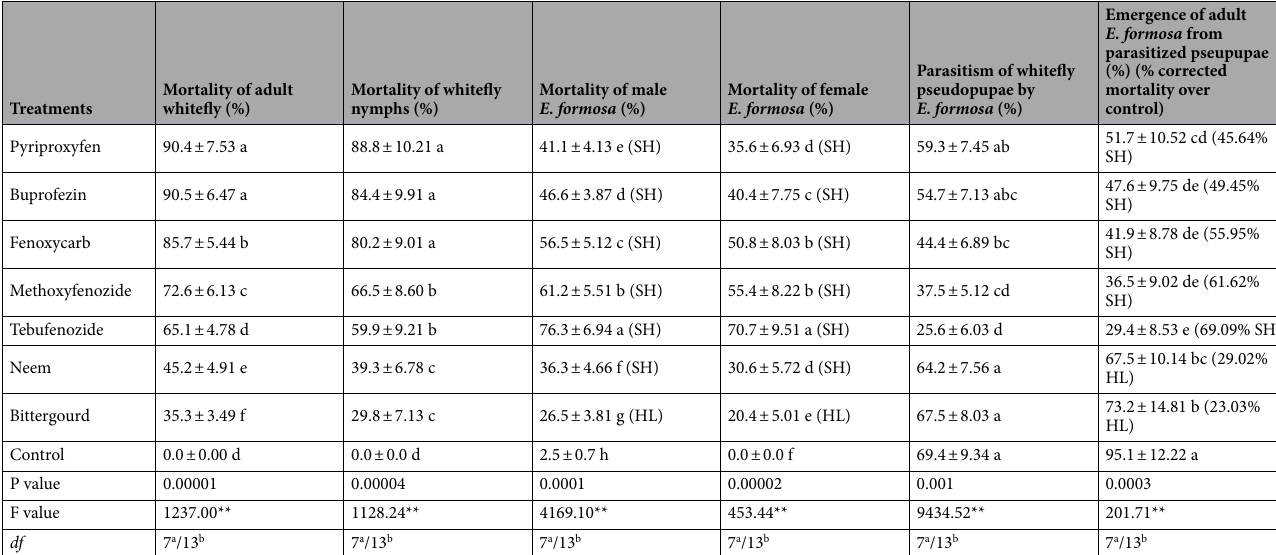
Table 4. Percent parasitism and adult emergence (mean ± SE) of E. formosa from parasitized pseudopupae and mortality (Mean ± SE) of adult and nymphs of whitefly and males and females of parasitoid ( E. formosa ) under laboratory conditions. Means with the same lowercase letters are not significantly different at α = 0.05 (Tukey’s test). Values in parenthesis indicate the corrected percent mortality of E. formosa inside the parasitized whitefly pseudopupae over control at 72 h PAEI. HL, SH, MH and HF abbreviations inside the parenthesis indicate Harmless/Class-I, Slightly-harmful/Class-II, Moderately-harmful/Class-III and Harmful/Class-I insecticides, respectively. a Degree of freedom of treatment. b Degree of freedom of error. **Highly significant at probability level of